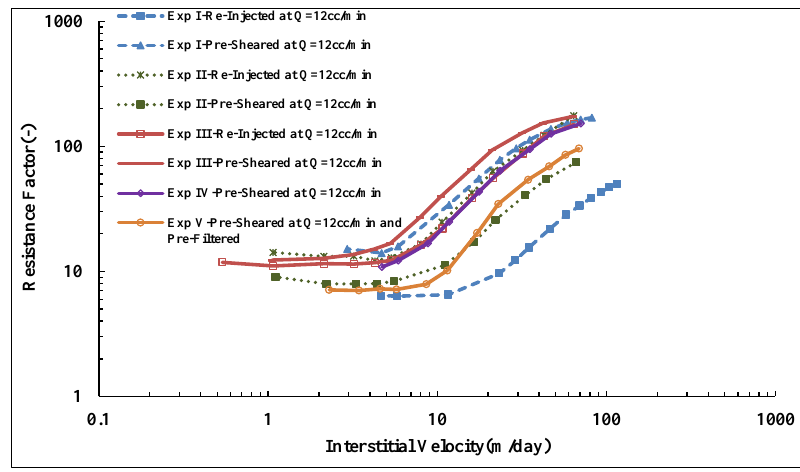
Figure 1. Reproduced resistance factor vs. interstitial velocity of presheared and reinjected solution 2 Figure 15. Reproduced resistance factor vs. interstitial velocity of pre-sheared and reinjected Solution